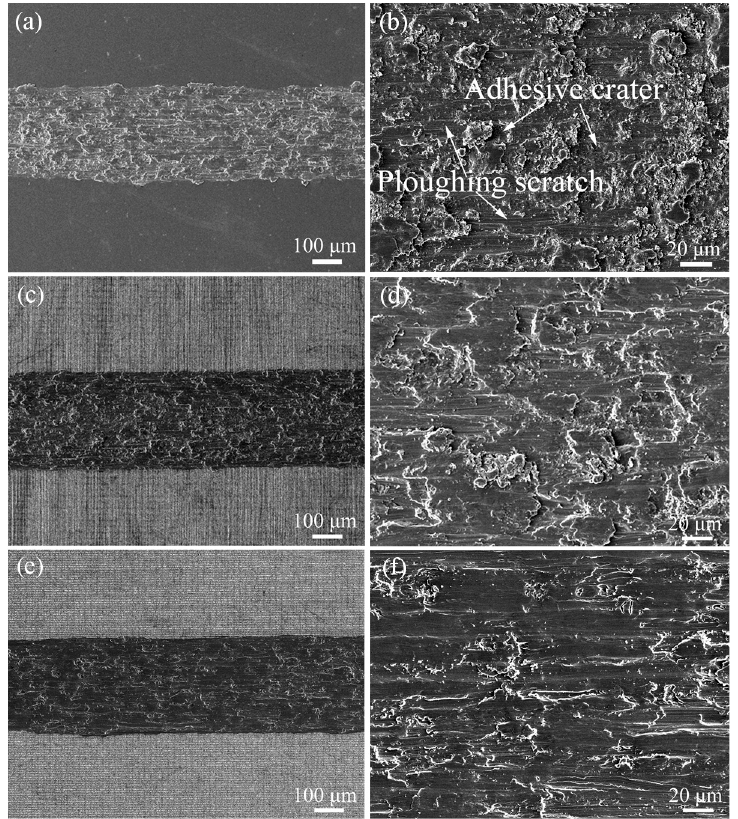
Figure 5. SEM micrographs of the wear tracks under the dry condition. ( a , b ) Wear tracks of smooth surface (SS); ( c , d ) Wear tracks of LIPSS-90; ( e , f ) Wear tracks of LIPSS-0.